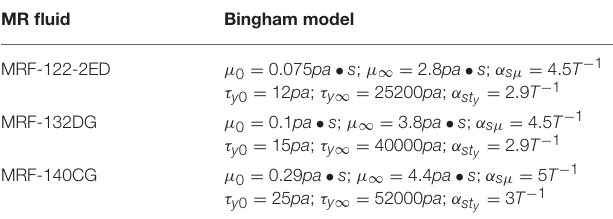
TABLE 2 | Rheological properties of MR